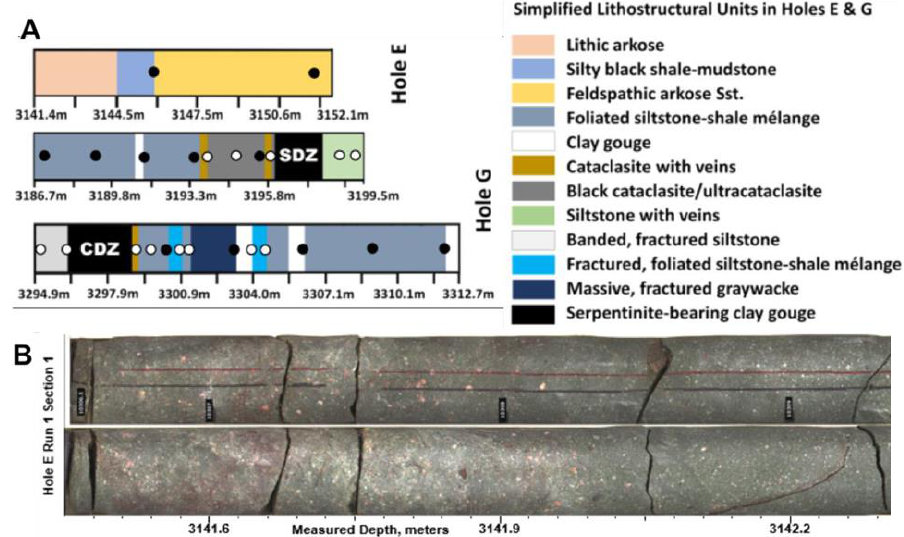
Figure 2. ( A ) General lithological characteristics of SAFOD core sections with a legend for units (measured depth-MD-meters). Black and white circles represent the distribution of sample billets (adapted from [26]). ( B ) Color photo of Hole E, Run 1, Section 1 including red and black core orientation lines (adapted from [27]).